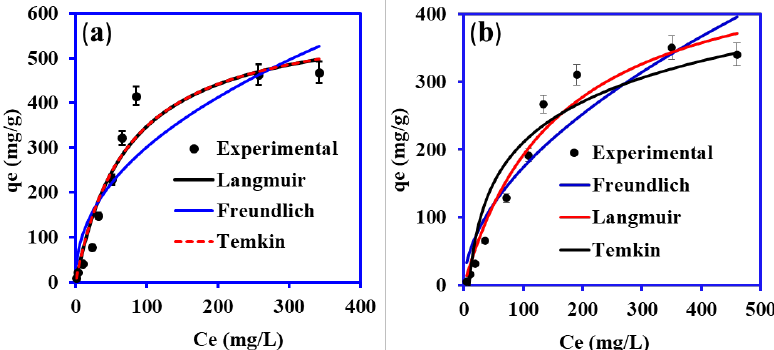
Figure 7. Adsorption isotherm plots for ( a ) Cu(II) and ( b ) phenol onto PANI@WTP composite (ad- sorbent dosage, 0.02 g; volume, 20 mL; contact time, 5 h; temp, 30 °C; pH 5.2 for Cu(II), pH 5 for (adsorbent dosage, 0.02 g; volume, 20 mL; contact time, 5 h; temp, 30 ◦ C; pH 5.2 for Cu(II), pH 5 for phenol